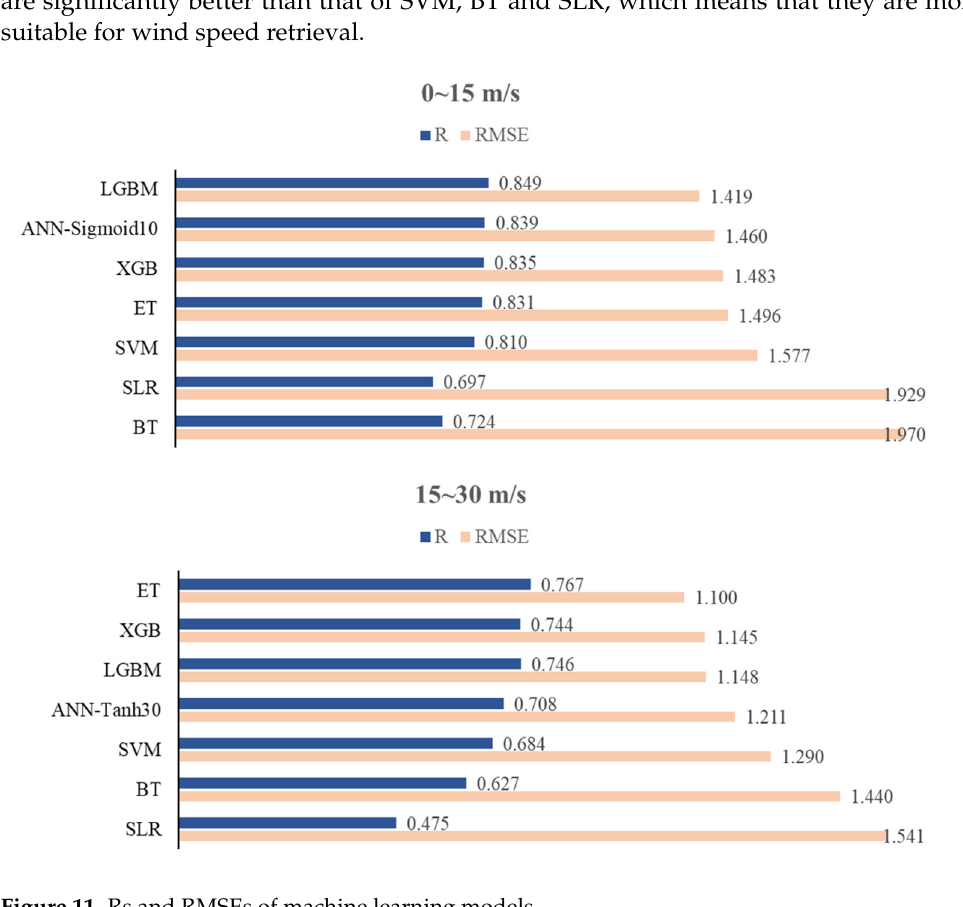
Figure 11. Rs and RMSEs of machine learning models.